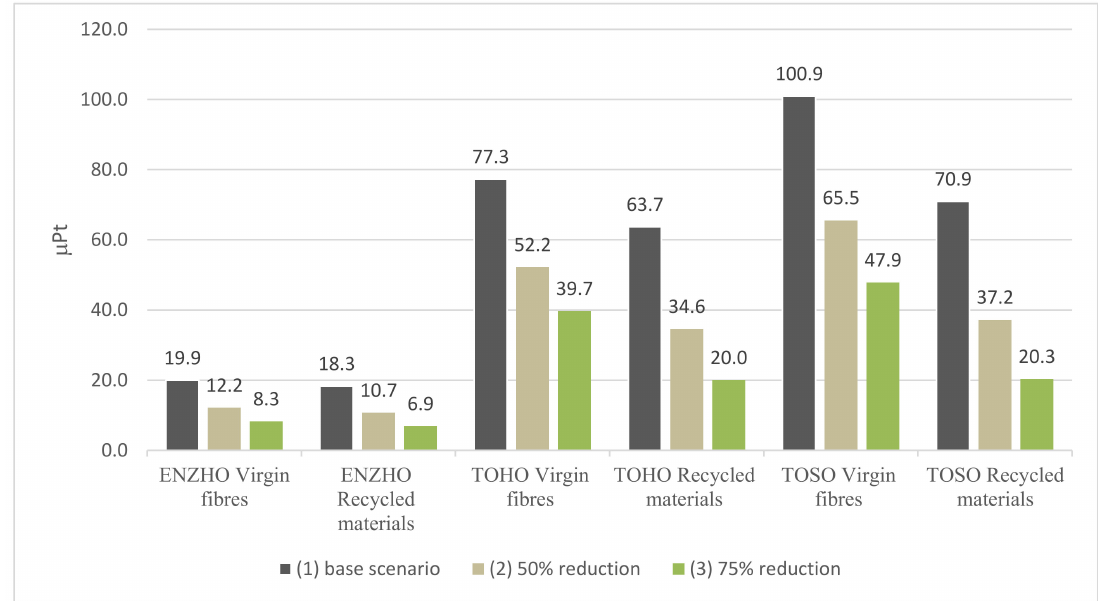
Figure 5. Single scores of the six CNFs in three scenarios: base scenario (1), the reduction of electrical energy consumption by 50% scenario (2), and the reduction of electrical energy by 75% scenario